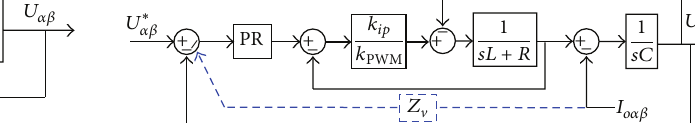
Figure 6: Block diagram of the voltage control loop.